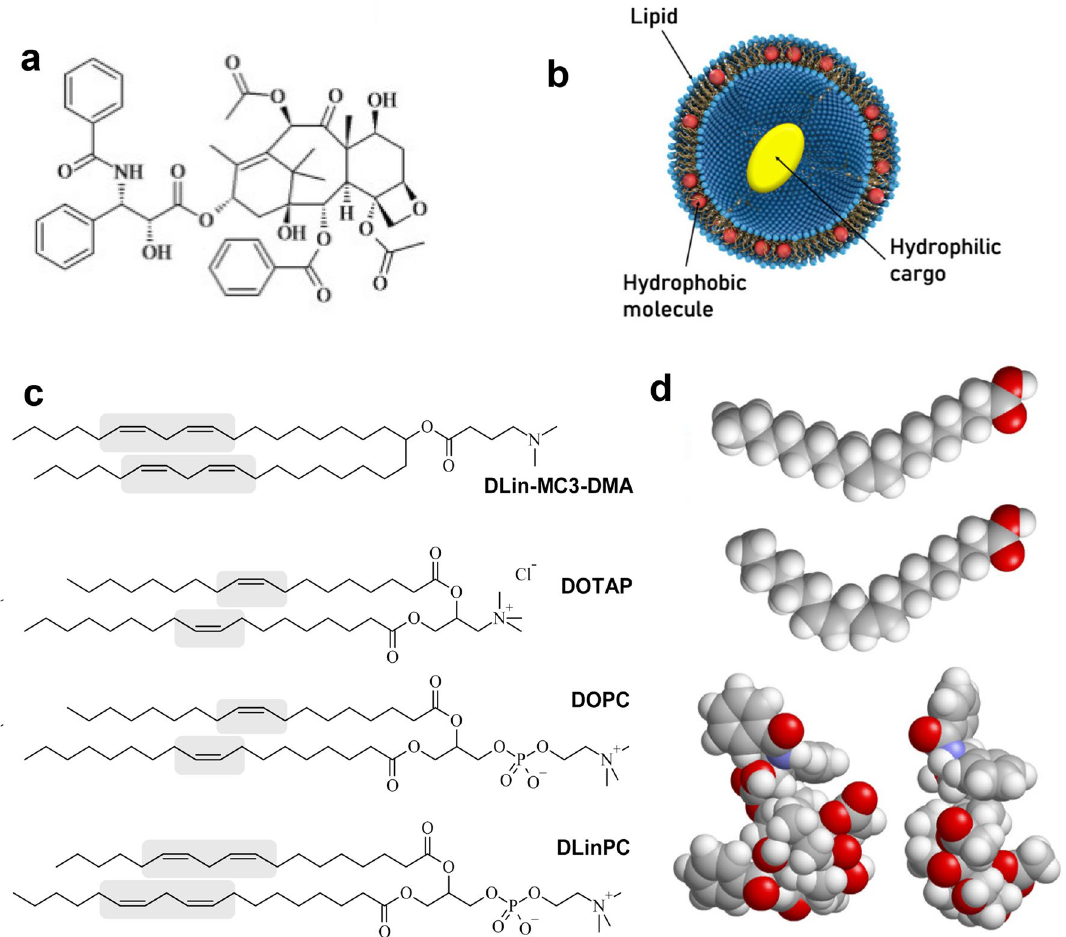
Figure 1. Paclitaxel (PTX) and lipid vectors. ( a ) Chemical structure of PTX. ( b ) A unilamellar liposome consisting of a self-assembly of amphiphilic lipid molecules. The liposome can carry hydrophobic molecules (red spheres) within its hydrophobic bilayer and hydrophilic molecules (yellow oval) in its aqueous interior. ( c ) Chemical Structures of DLin-MC3-DMA (the cationic lipid used in patisiran), DOTAP, DOPC (the lipids used in the Endo-TAG formulation of PTX) and DLinPC. The cis double bonds in the lipid tails are highlighted. ( d ) Space filling molecular models of the ground state structure of oleic acid (C18:1) and linoleic acid (C18:2) together with two views of the structure of PTX for size comparison. The structures were rendered using RasTop 2.2 (https:// www. genei nfini ty. org/